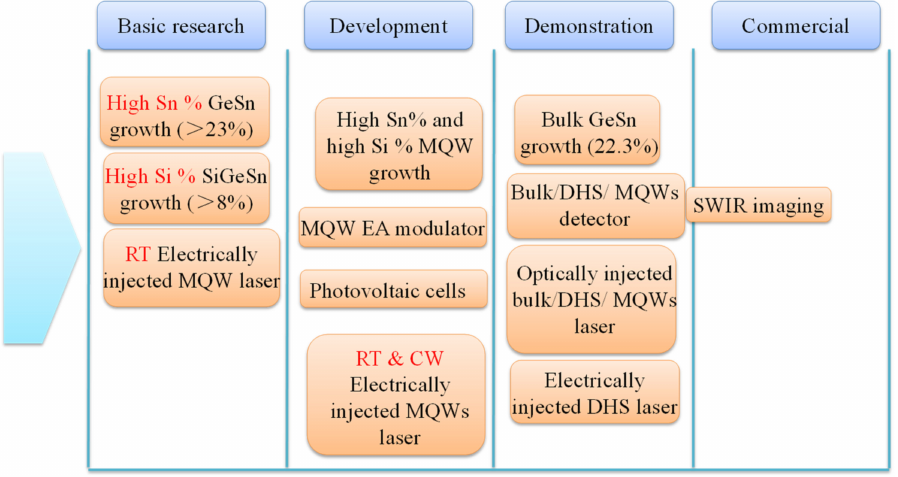
Figure 2. Optoelectronic applications of GeSn as a function of technology readiness level (GeSn transistors, which are still in the technical development stage, are not shown here due to space